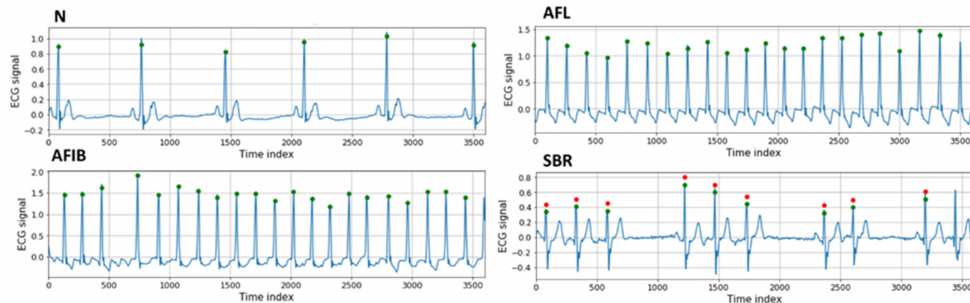
Figure 3. Representative ECG rhythm sequences.